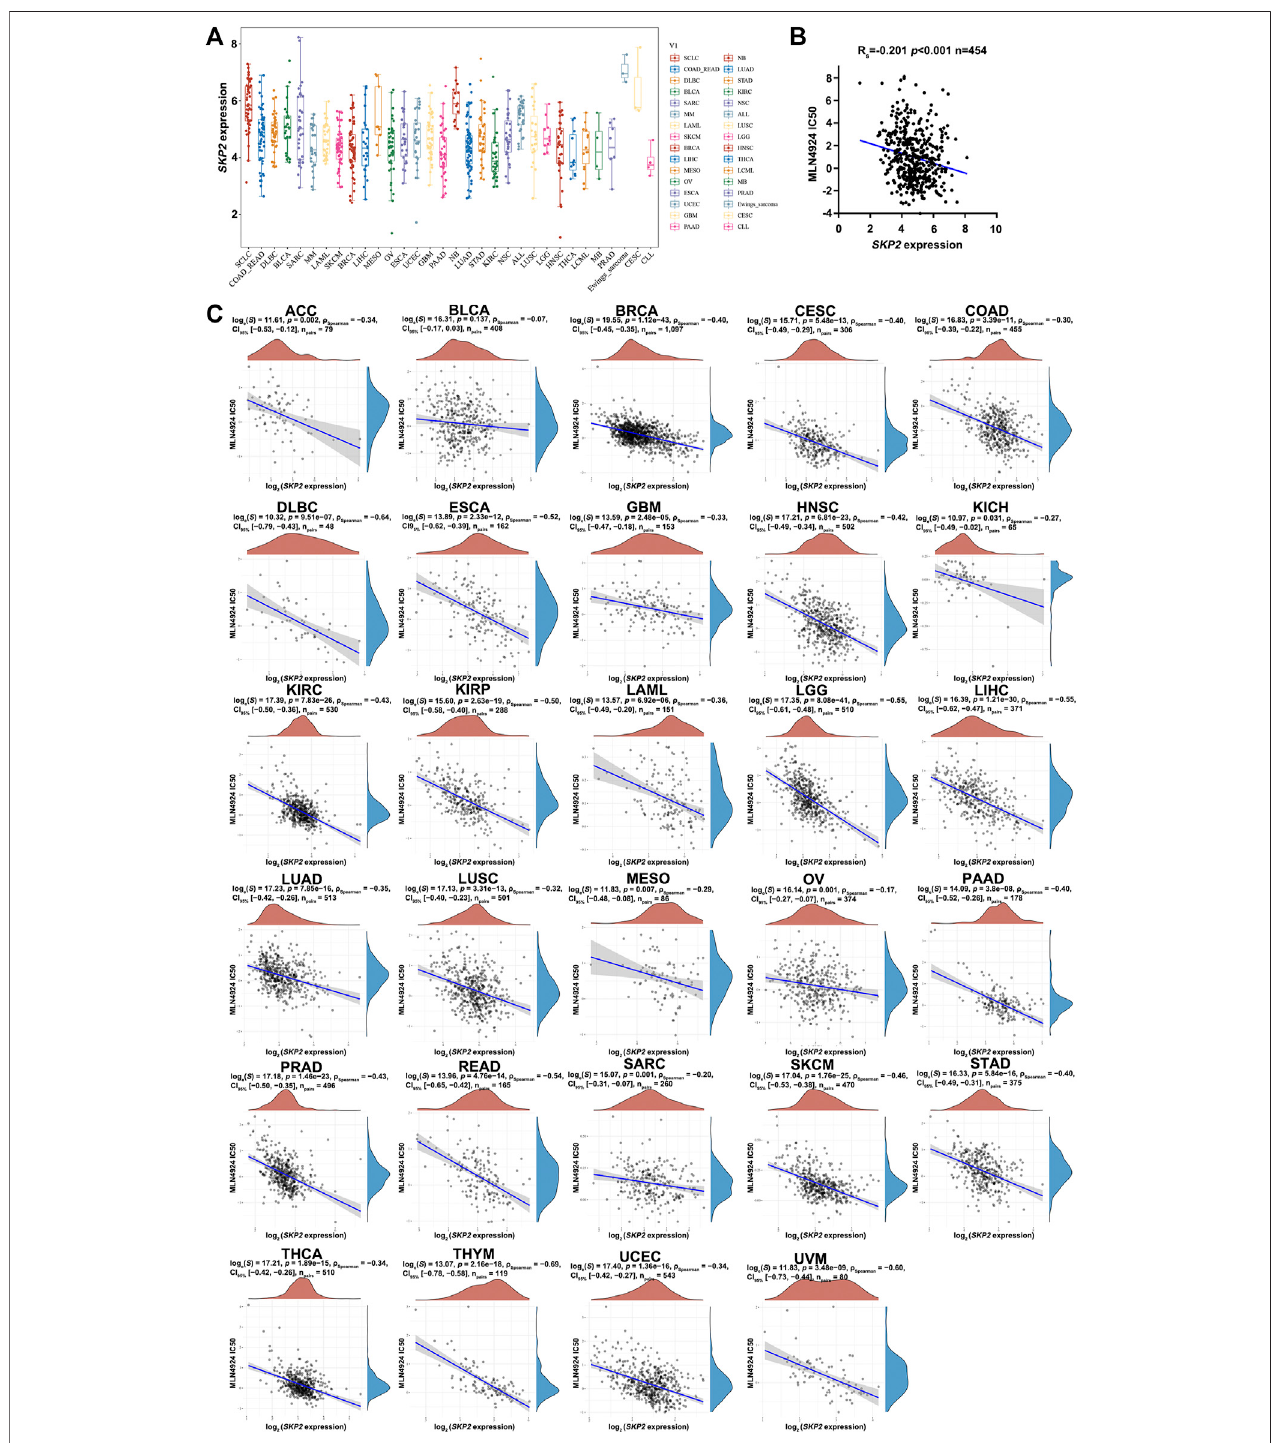
FIGURE9| Thenegativecorrelationbetween SKP2 expression andMLN4924IC50 scoreinpan-cancer (A) Theexpression distribution of SKP2 indifferenttumor tissues, where the horizontal axis represents samples from different groups, and the vertical axis represents the expression distribution of SKP2 . (B) MLN4924 IC50 values of 454 human cancer cell lines from the CCLE dataset were negatively correlated with SKP2 expression from the TCGA database. Spearman r and statistics are indicated. (C) Spearman correlation analysis of MLN4924 IC50 score and SKP2 mRNA expression in pan-cancer.